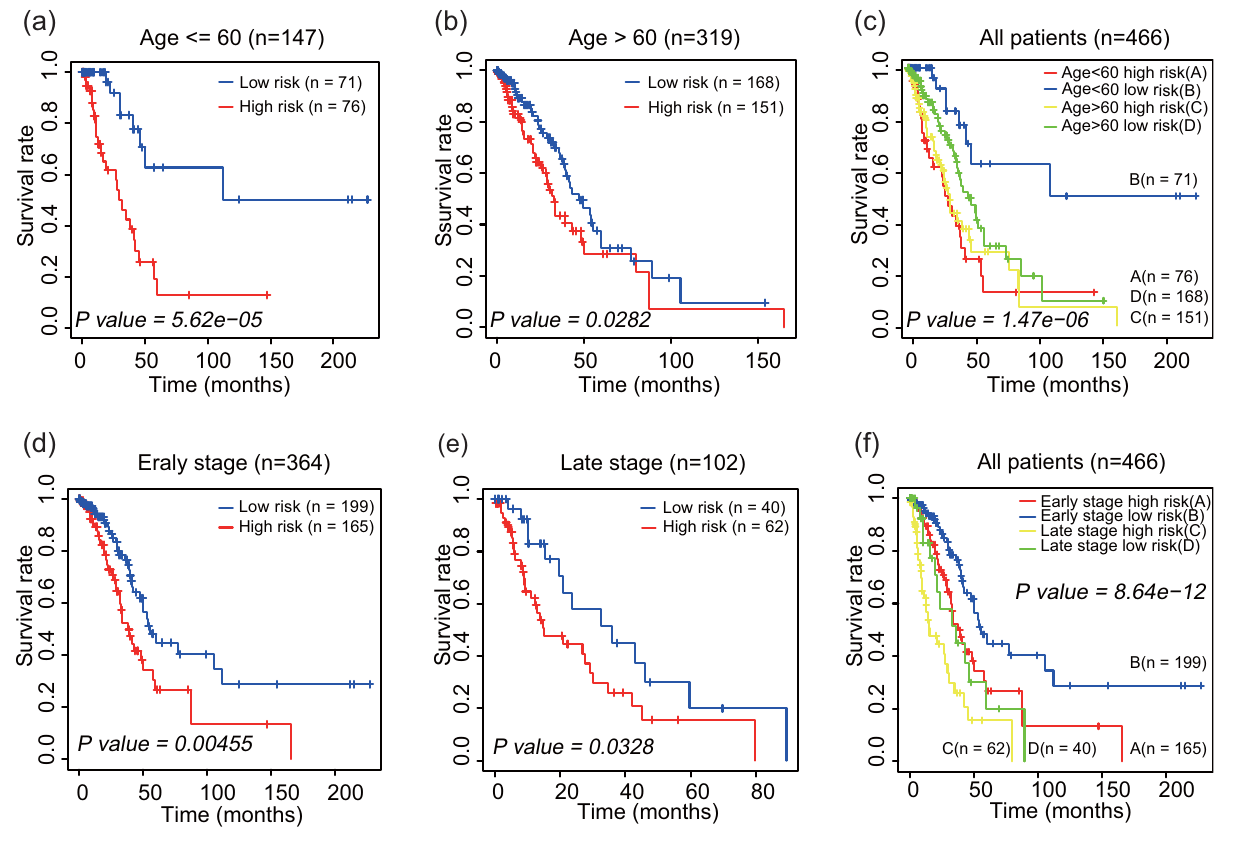
Figure 5: Analysis of associations of four - lncRNA in the groups with various age and tumor stages. ( a ) The Kaplan – Meier curve of young LUAD patients. ( b ) Kaplan – Meier curve of elderly LUAD patients. ( c ) The Kaplan – Meier curve of the entire LUAD patients. ( d ) The Kaplan – Meier curve of LUAD patients in early stage. ( e ) Kaplan – Meier curve of LUAD patients in late stage. ( f ) The Kaplan – Meier curve of the entire LUAD patients. The P value represents the di ff erence between the two curves according to two - sided log rank test